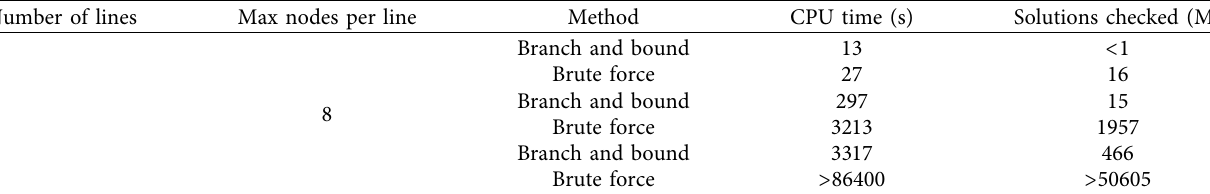
Table 10: Comparison of the branch and bound with a brute force algorithm.